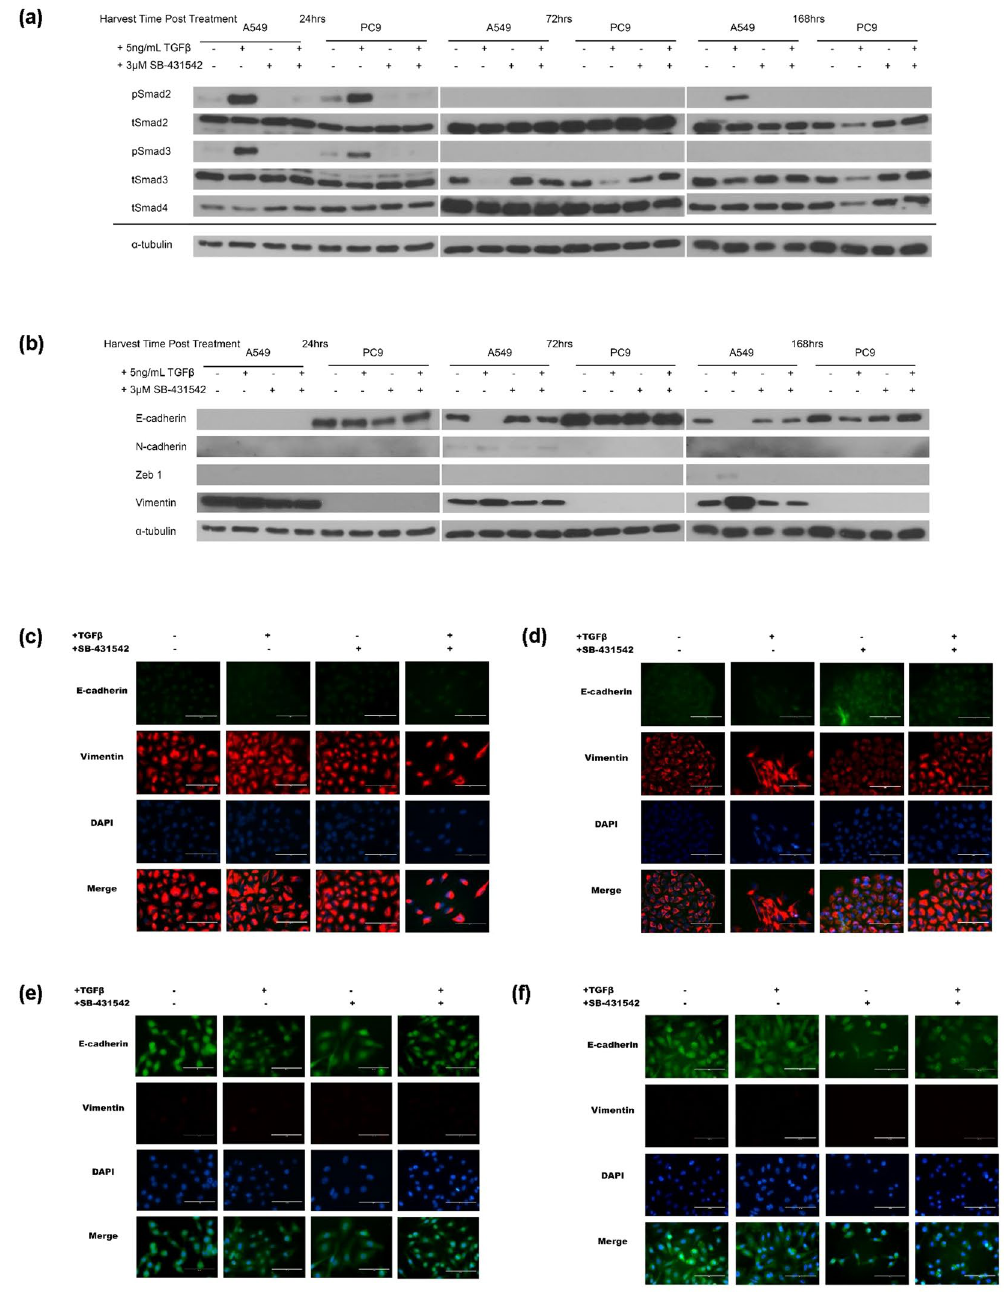
Figure 2. Total Smad expression, Smad activation and EMT program marker expression varies with TGF β or inhibitor treatment. A549 and PC9 cells were plated, treated and harvested as described. Proteins were visualized by western blotting. α -tubulin levels are representative controls. ( a ) Profiling of Smad family member expression and activation across time demonstrates changes in TGF β canonical signalling. ( b ) EMT protein markers demonstrate program initiation and progression among treatment conditions. ( c ) A549 cells treated for 24 hours for E-cadherin and Vimentin expression by immunofluorescence ( d ) A549 cells treated for 7 days for E-cadherin and Vimentin expression by immunofluorescence ( e ) PC9 cells treated for 24 hours for E-cadherin and Vimentin expression by immunofluorescence ( f ) PC9 cells treated for 7 days for E-cadherin and Vimentin expression by